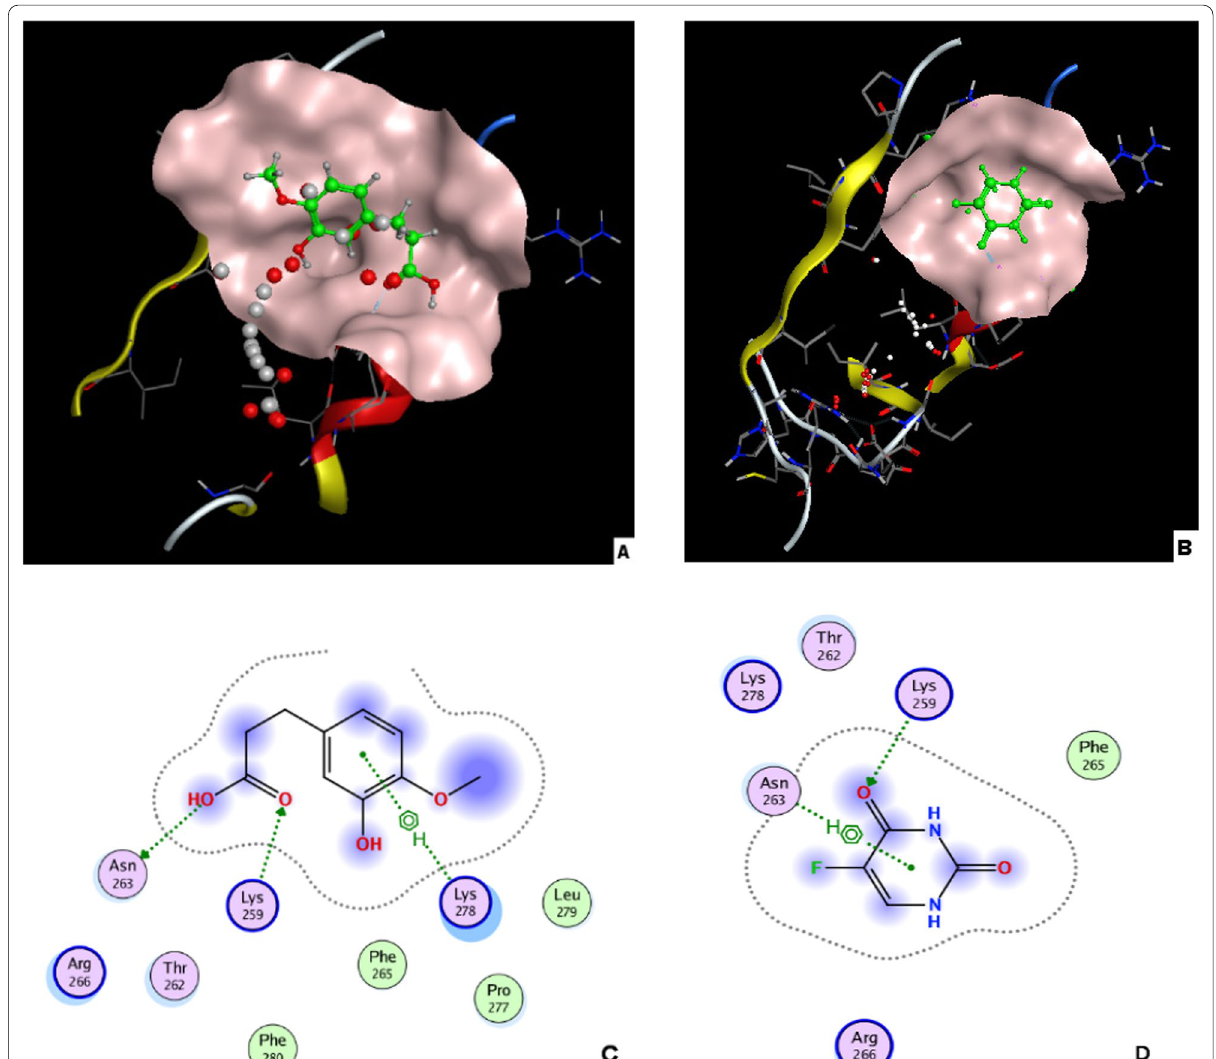
Fig. 2 Molecular docking of Caspase-3 (PDB: 1RHR), A : 3D interaction diagram with FA, B : 3D interaction diagram with 5FU, C : 2D interaction diagram with FA, D : 2D interaction diagram with